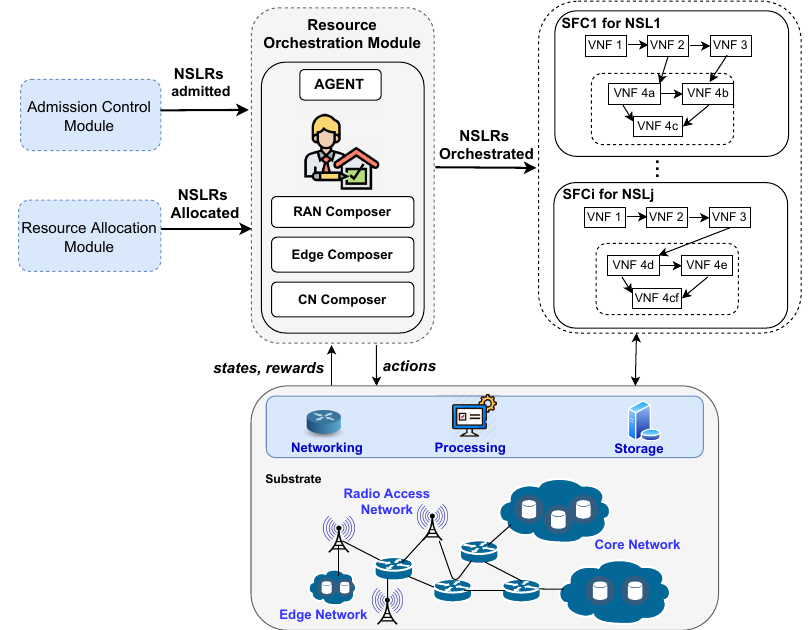
Figure 5. Resource orchestration architecture using